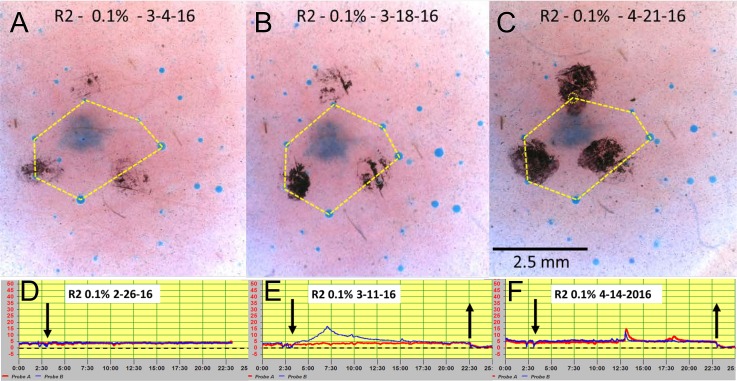
C-sweat responses at site R2 to injection of 0.1% strength cocktail measured with the bubble method and with evaporimetry.This site was chosen because it showed the largest evaporimetry response seen to 0.1% cocktail. (A-C) show bubble responses, the same 6 glands were connected by thin yellow lines in each image except for (C), where no bubble was visible at the apex of the hexagram (dotted circle). (D-F) show evaporimetry responses at the same site offset by one week. All other descriptors are as for Fig 2. The largest evaporimetry response to 0.1% cocktail is shown in (E). Excursions in (F) are artifacts of unknown cause. Down arrow: probe B on; up arrow: probes off.